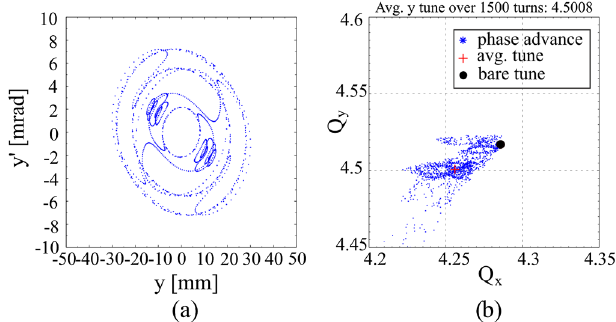
time.FIG. 15. A particle tracked at 485 ms [on the solid magenta line in Fig. 4(a)] before getting vertically lost by scattering. The turn- by-turn tracking is represented with blue dots the vertical phase space (a) and in the tunes plane (b).